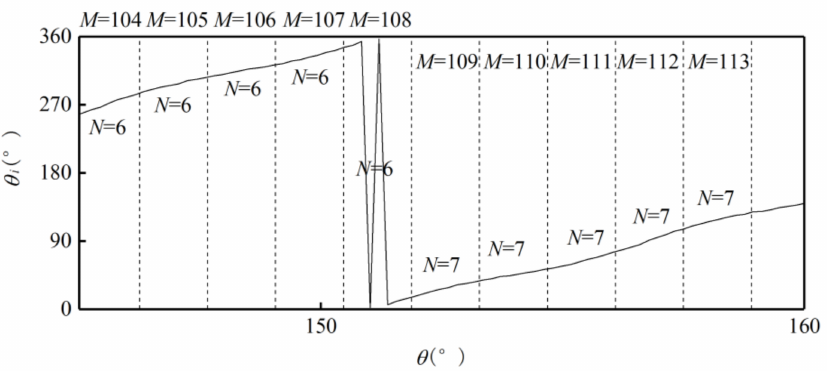
Figure 8. Primary corresponding relationship between intervals and pole positions.